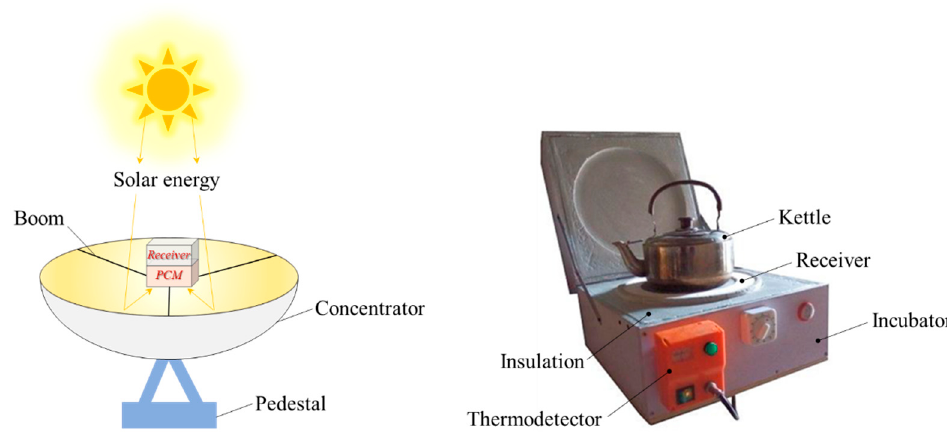
Figure 4. Experimental test.